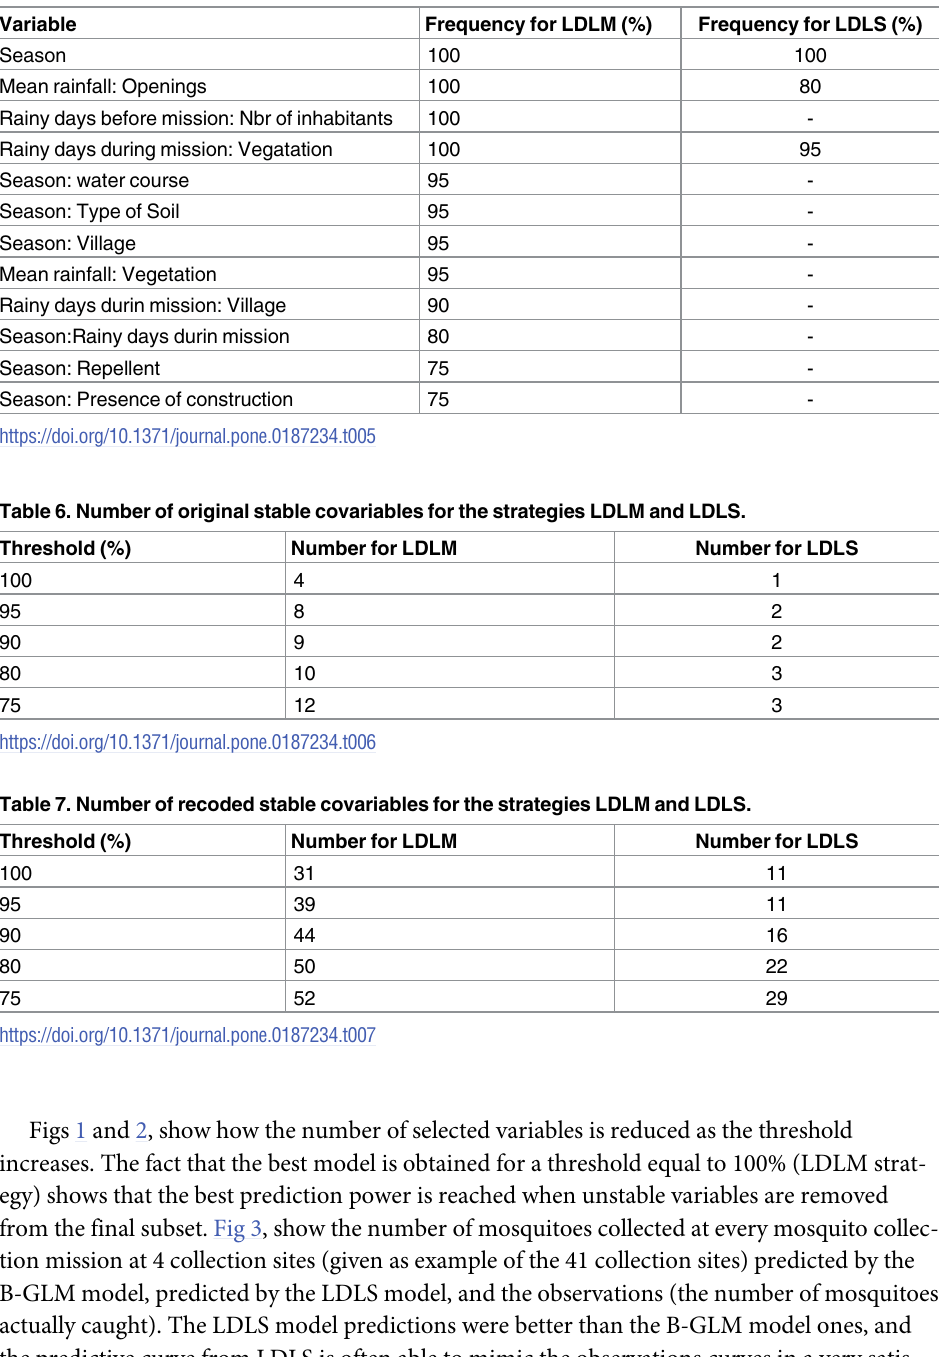
Table 5. Frequency of original stable